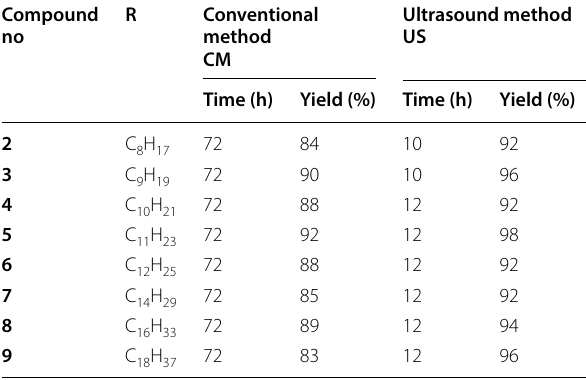
Table 1 Times and yields of halogenated pyridinium hydrazones 2–9 under conventional and